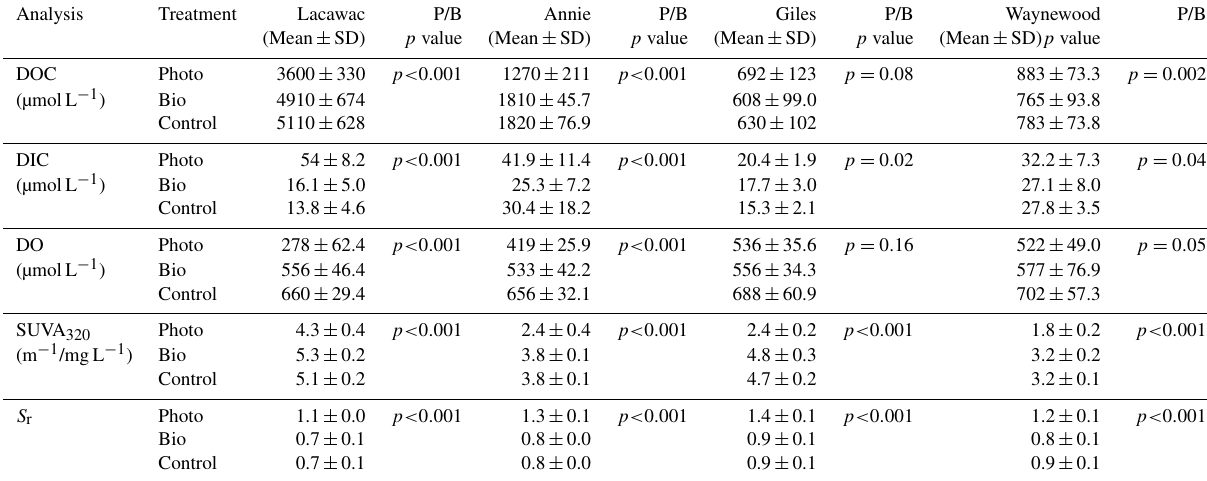
Table 2. A summary of the mean ( ± SD), final concentration of DOC, DIC, DO, SUVA 320 , and S r in photodegradation (Photo), biodegra- dation (Bio), and control experimental treatments in groundwater samples from the watersheds of lakes Lacawac, Annie, Giles, and Waynewood. The mean ( ± SD) initial concentration for each variable is also depicted. The P/B column lists the results of a t test to de- termine whether photodegradation (P) samples were significantly different from the biodegradation (B) samples ( n = 12 for each treatment for the 4 months). Bolded values indicate the Photo treatments that were statistically different from the Bio treatments ( p< 0 . 05).